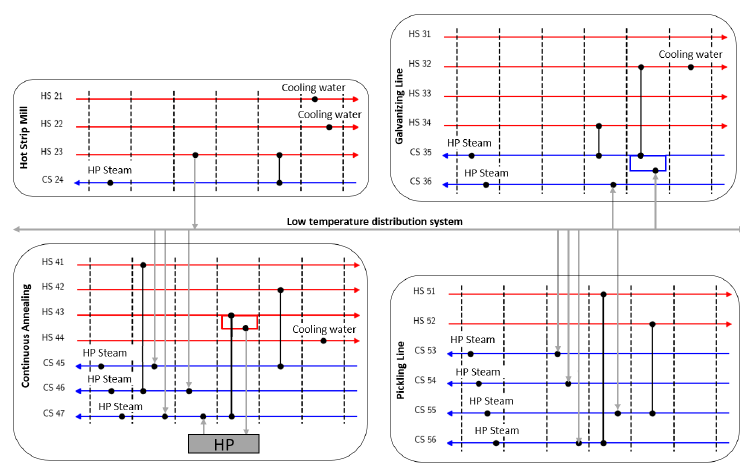
Figure 15. heat exchanger network (HEN) for storyline A and price scenario